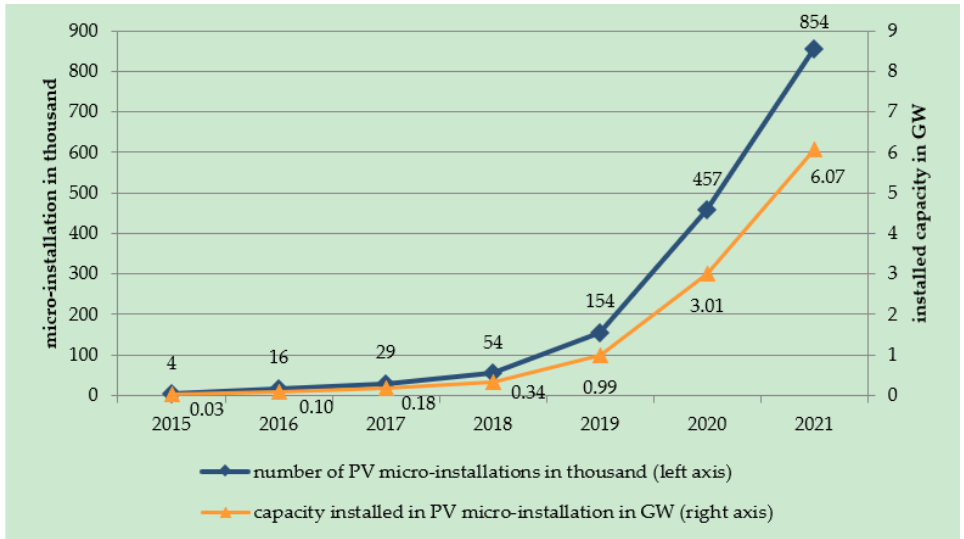
Figure 2. Installed capacity and the number of PV micro-installations (<50 kWp) in Poland in 2015–2022. Based on data from [78].